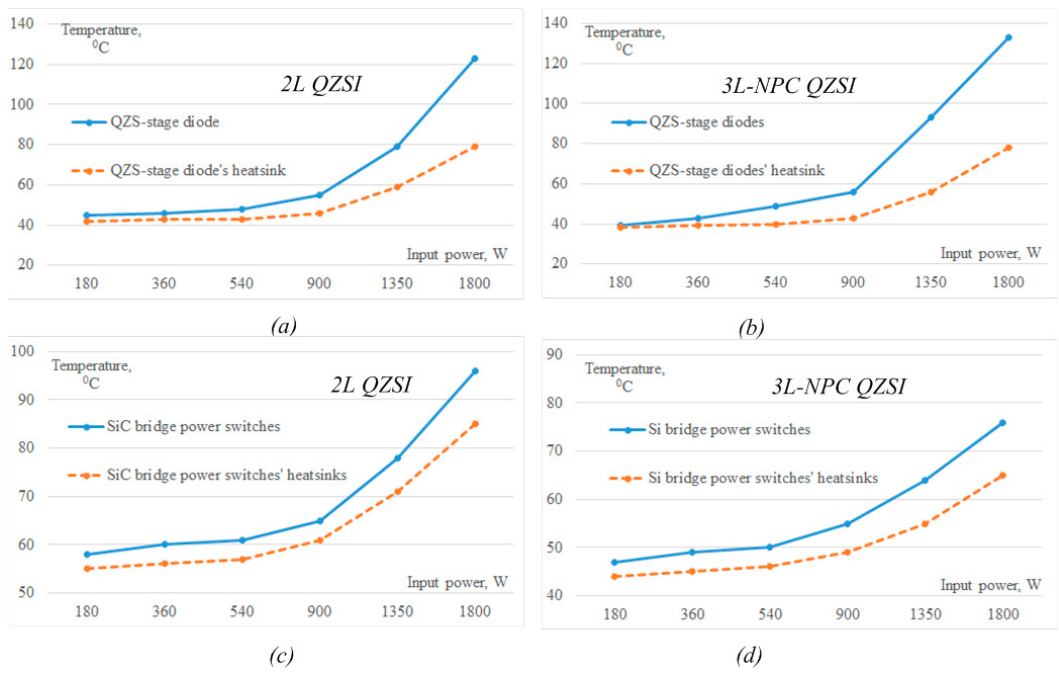
Figure 10. Temperatures of the QZS-stage diode and heatsink in the 2L QZSI ( a ) and 3L NPC QZSI ( b ), temperatures of the SiC bridge power switches and heatsinks in the 2L QZSI ( c ), and temperatures of the Si bridge power switches and heatsinks in the 3L NPC QZSI ( d ).